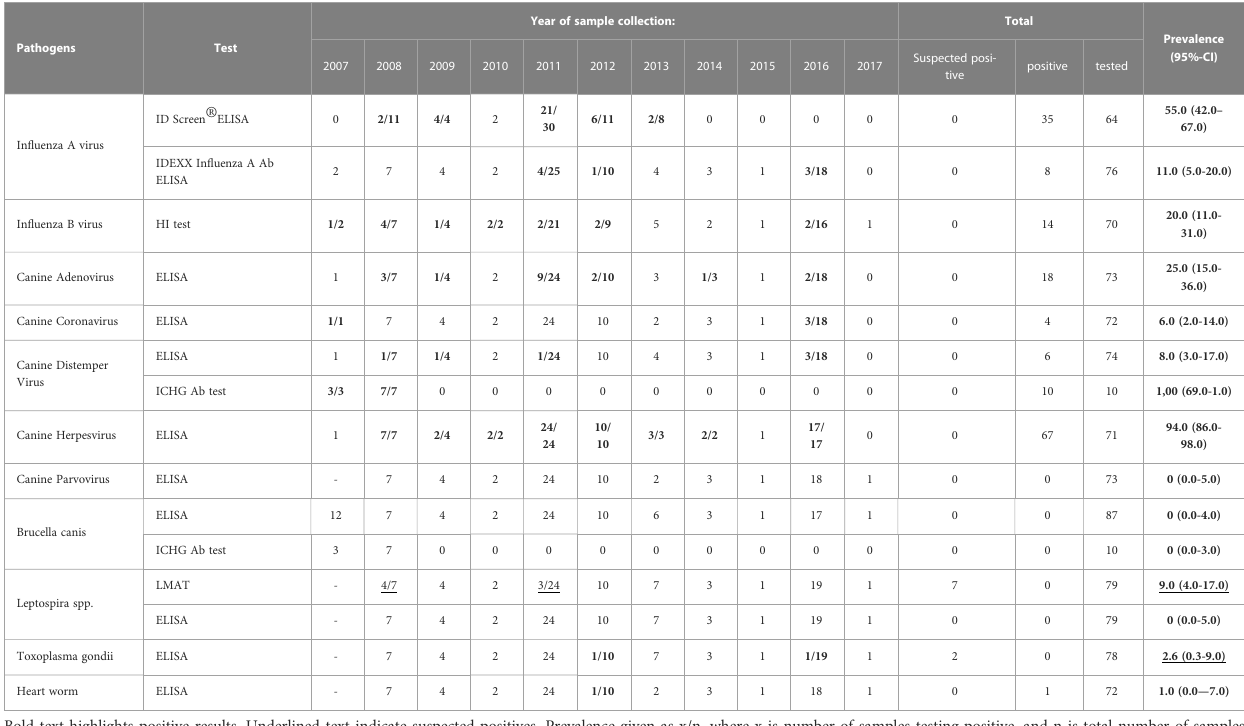
TABLE 2 IgG Antibody prevalence of selected pathogens in Caspian seals.